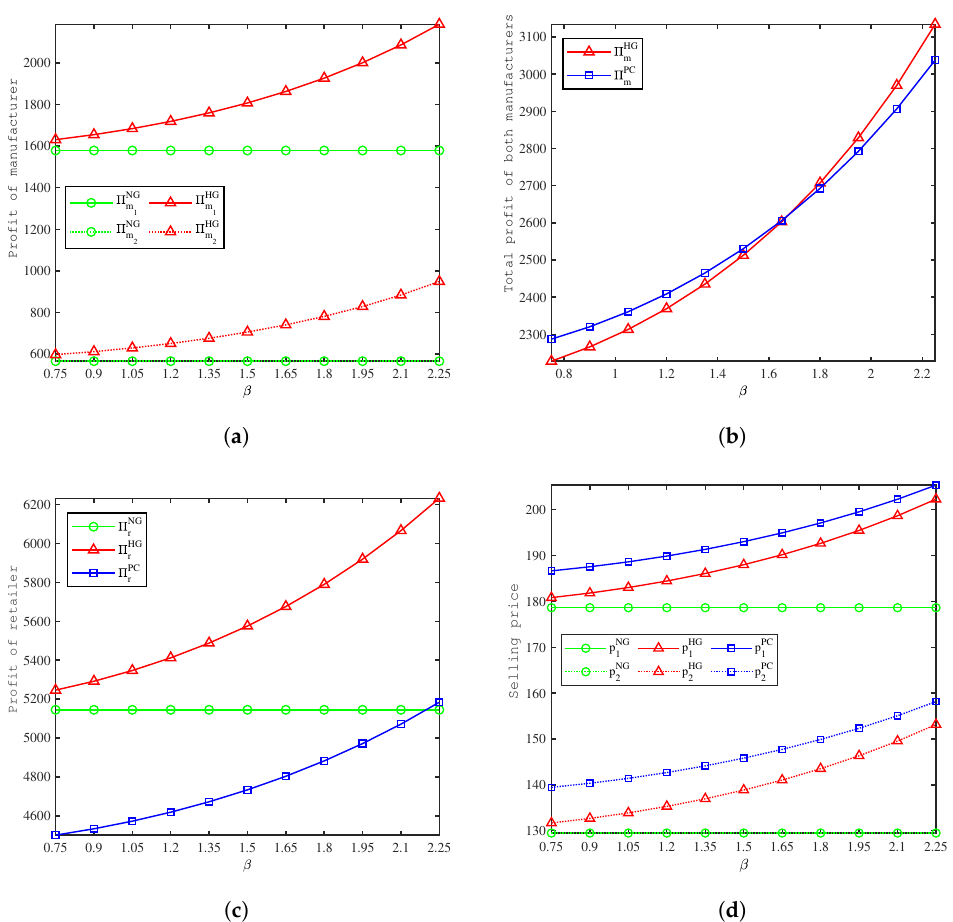
Figure 5. Comparison of the profit between models. ( a ) Effects of β on the manufacturers’ profits. ( b ) Effects of β on the manufacturers’ total profits. ( c ) Effects of β on the retailer’s profits. ( d ) Effects of β on the selling